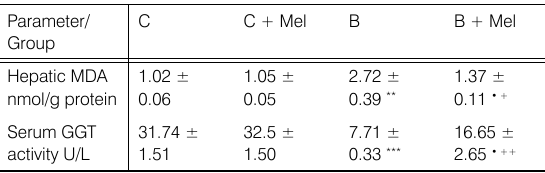
C, vehicle treated rats without burns, intact rats; C + Mel, intact rats treated with melatonin; B, vehicle treated rats with burns; B + Mel, melatonin treated rats with burns **p < 0.001, ***p < 0.0001: B versus C; + p < 0.01, ++ p < 0.001: B + Mel versus C; • p < 0.01: B + Mel versus B. Results are given as mean ± SEM Table 2. Hepatic protein contents, serum albumin and serum ChE activity after burns in rats Parameter/ Group